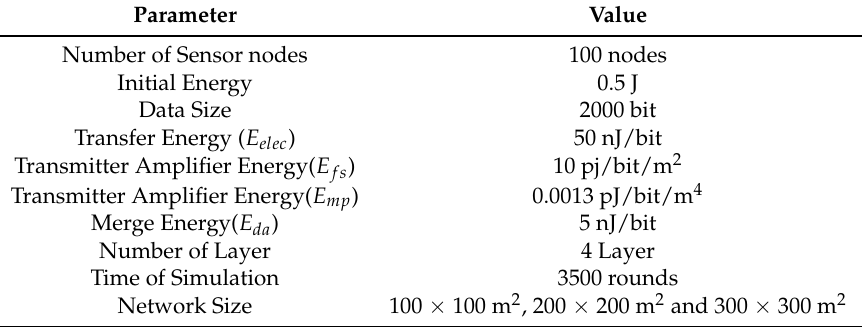
Table 1. Parameters of the